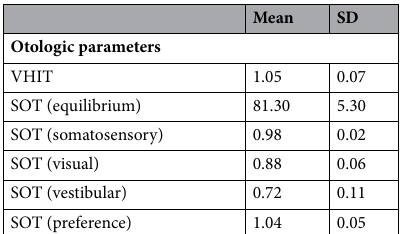
Table 1. Baseline characteristics of total participants. SD standard deviation, SSQ Simulator Sickness Questionnaire, STAI State-Trait Anxiety Inventory, NRS Numeric Rating Scale, PSS-10 Perceived Stress Scale,